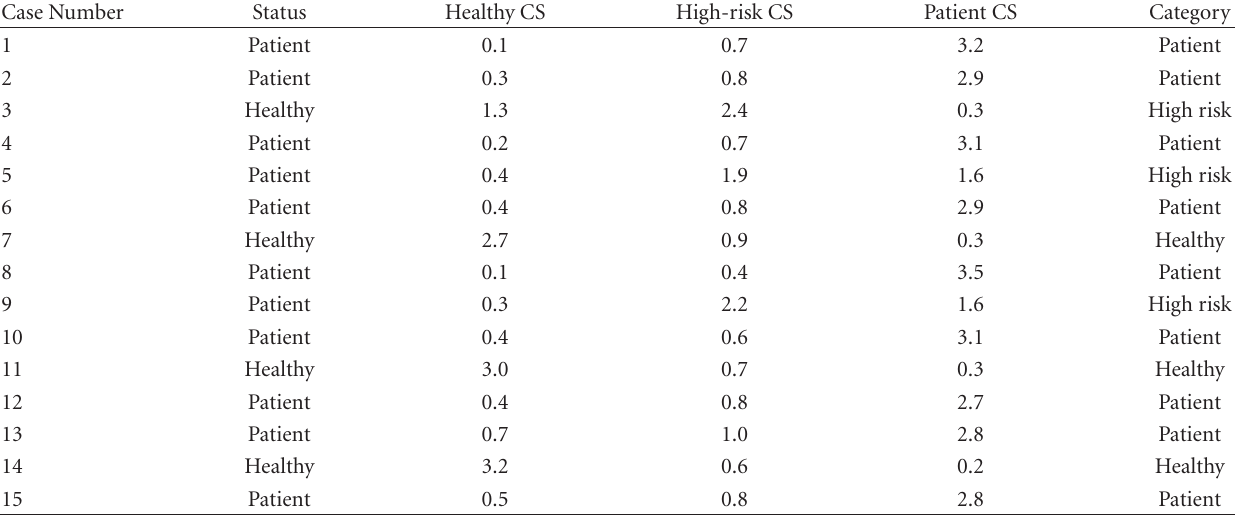
Table 6: Results of algorithm testing on the third